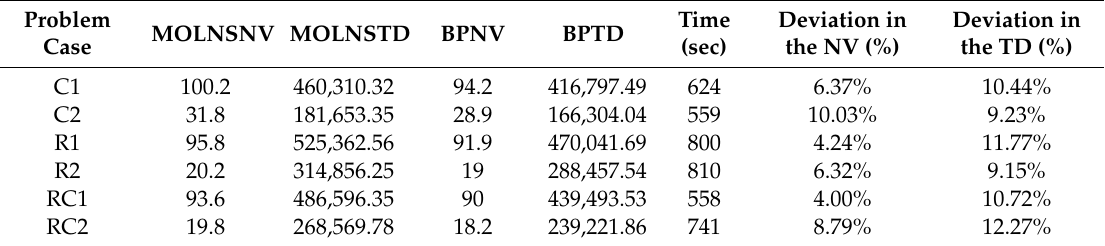
Table 3. Gehring and Homberger’s instances with 1000 customers: comparison of our MOLNS with the best-published